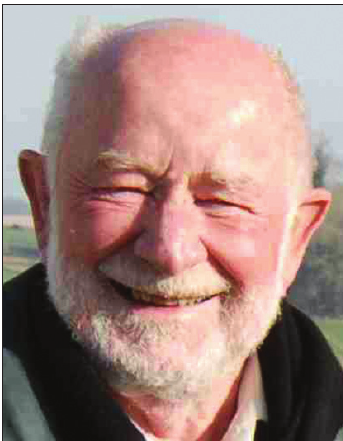
Figure 4: Geoffrey Wainwright (Photo Timothy Darvill).